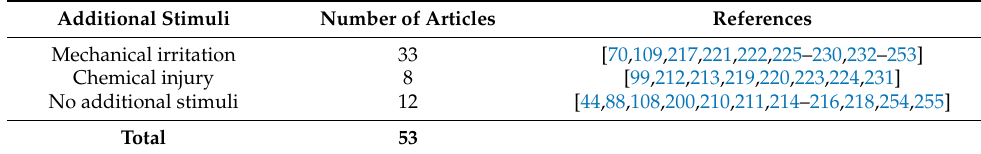
Table 6. Additional stimuli used in oral mucositis animal models other than the chemotherapeu- tic